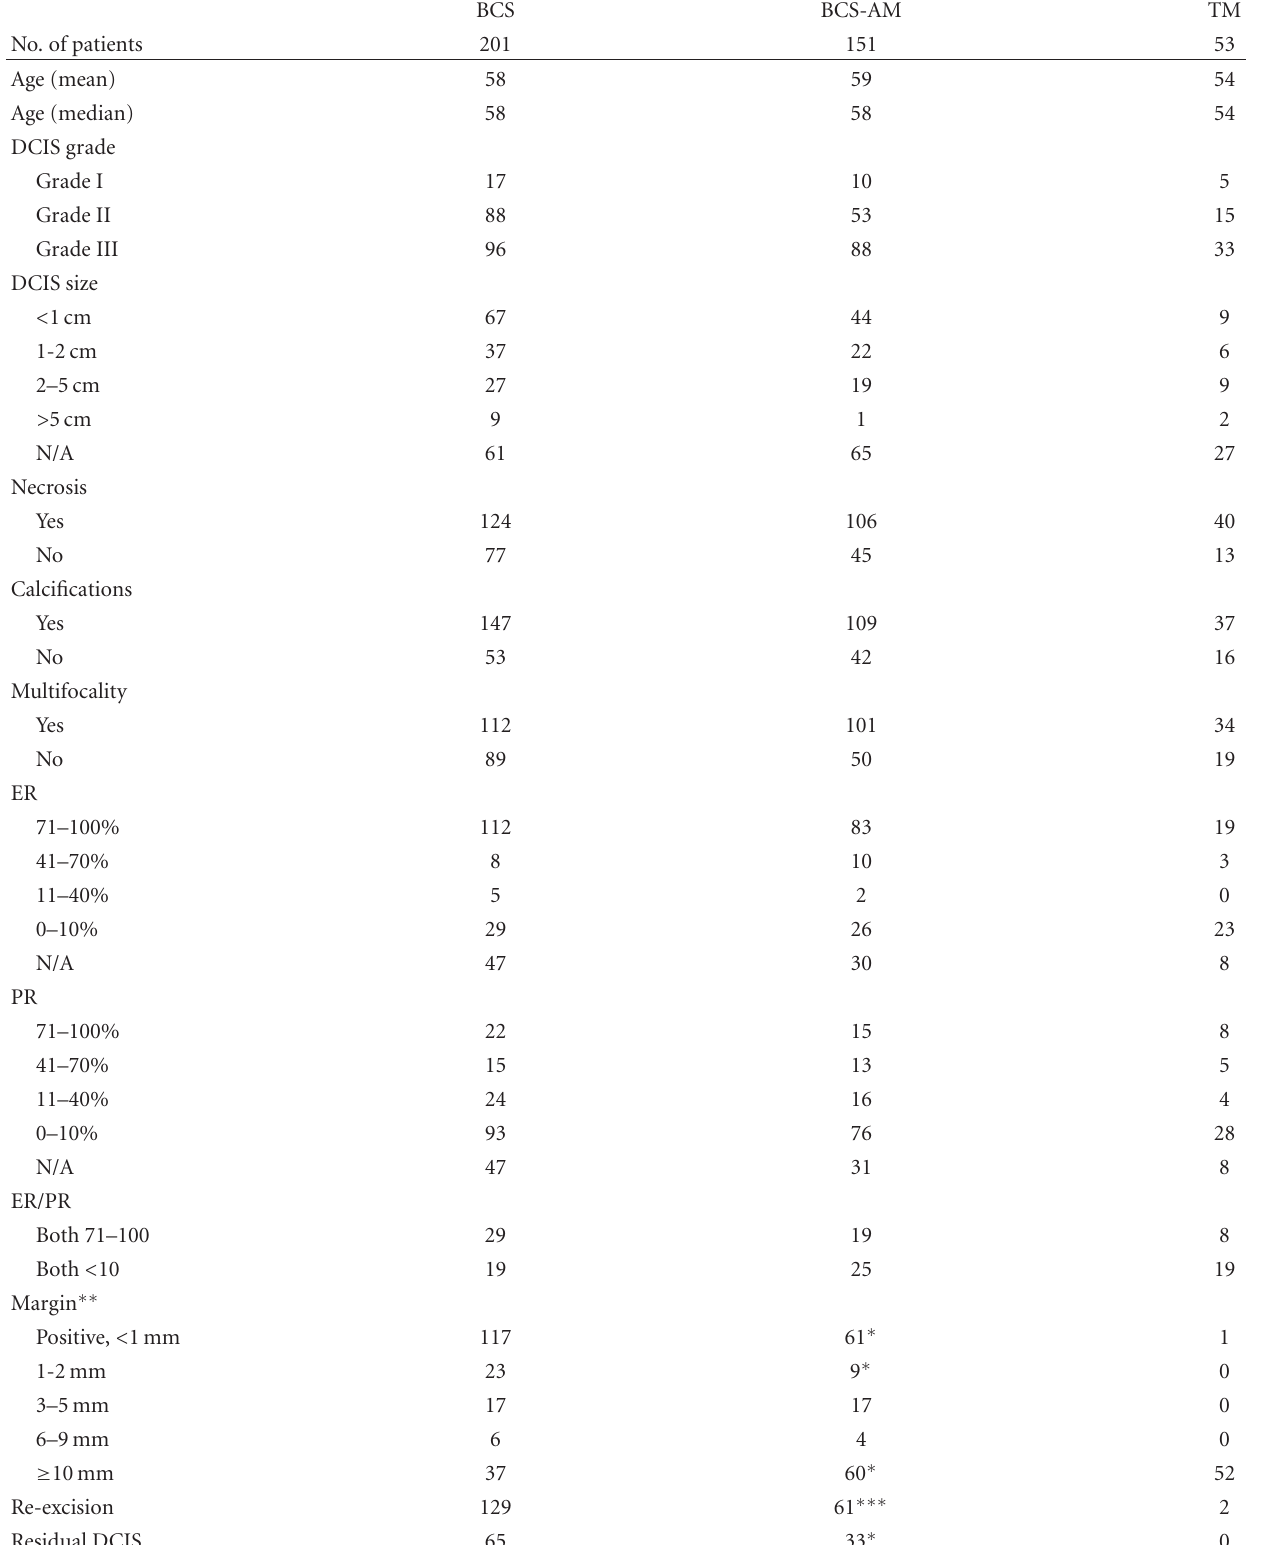
(a) Comparison of patients who underwent BCS, BCS-AM, and TM